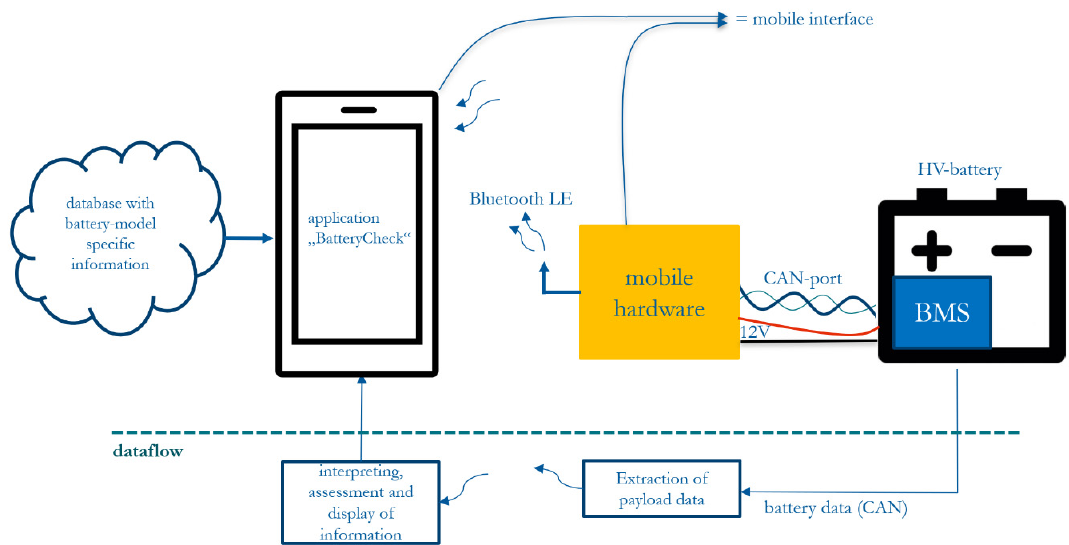
Figure 8. Complete conceptual overview of the mobile interface and information flow: the mobile hardware reads battery data from a BMS wire-bound, extracts the payload information and transfers it wirelessly to the application “BatteryCheck”, where the data are decoded and evaluated based on model-specific information stored in a database.